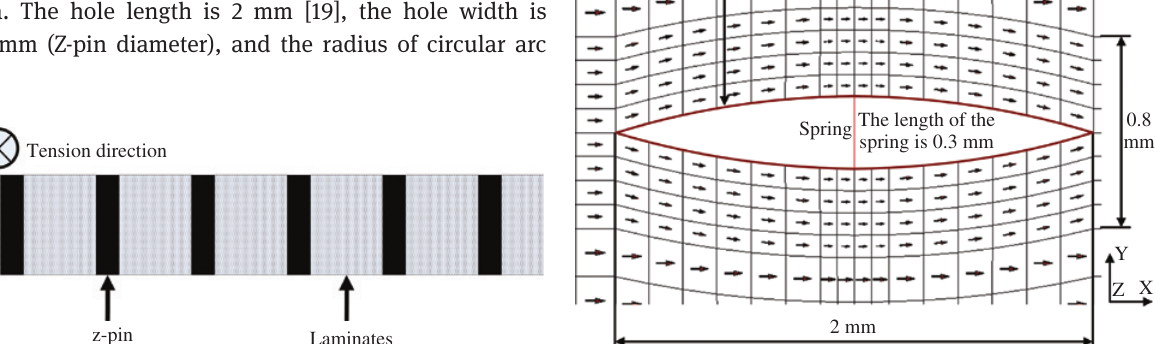
Figure 8: Deflection fiber tape around the hole.